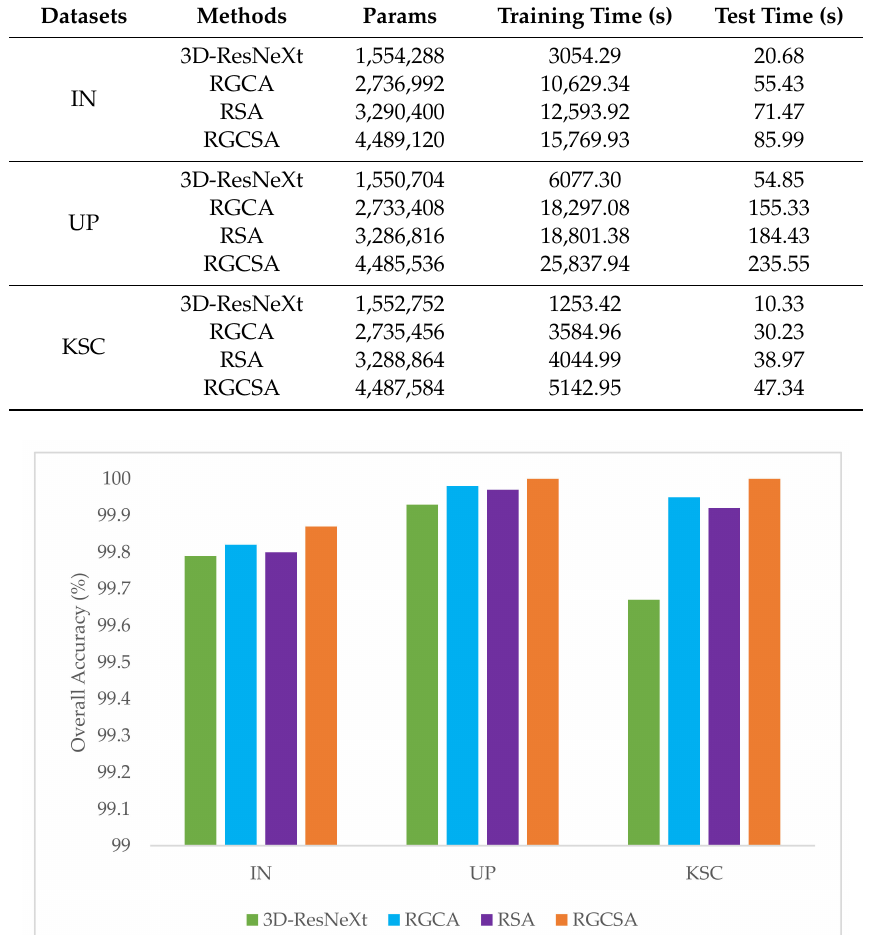
Table 14. Params, training time, and test time for di ff erent attention mechanisms on the IN, UP, and KSC datasets.